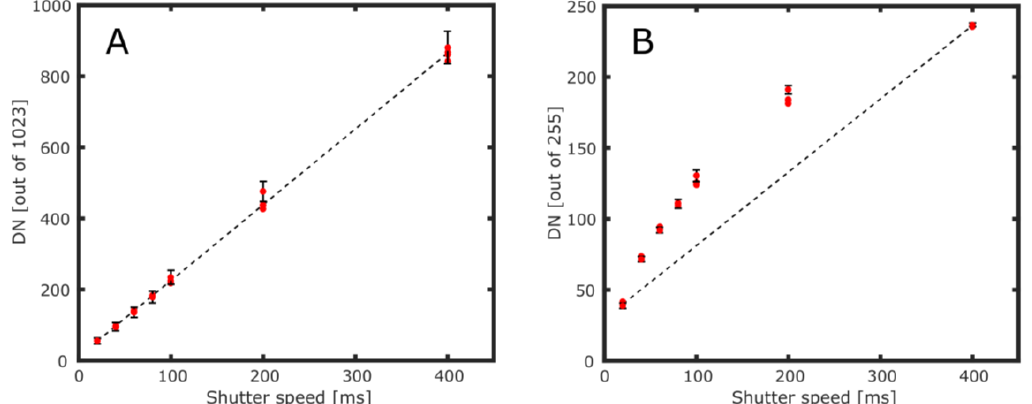
Figure 3. Plots of average pixel signal (in digital number; DN) vs. shutter speed (ms) for a cropped region (800 × 600 pixels) of clear-sky images taken at 310 nm: ( A ) the 10-bit RAW image output shows a linear increase in DN with respect to shutter speed; ( B ) the 8-bit standard output JPEG image shows a non-linear response in all three of the red-green-blue (RGB) channels (Red-channel DNs are plotted here) in line with gamma correction. An error bar is inserted on one data point per exposure time, indicating the standard deviation of the pixel intensities in the cropped region; the bar heights are approximately the same for all points of equivalent shutter speed, and just one bar is displayed for clarity.